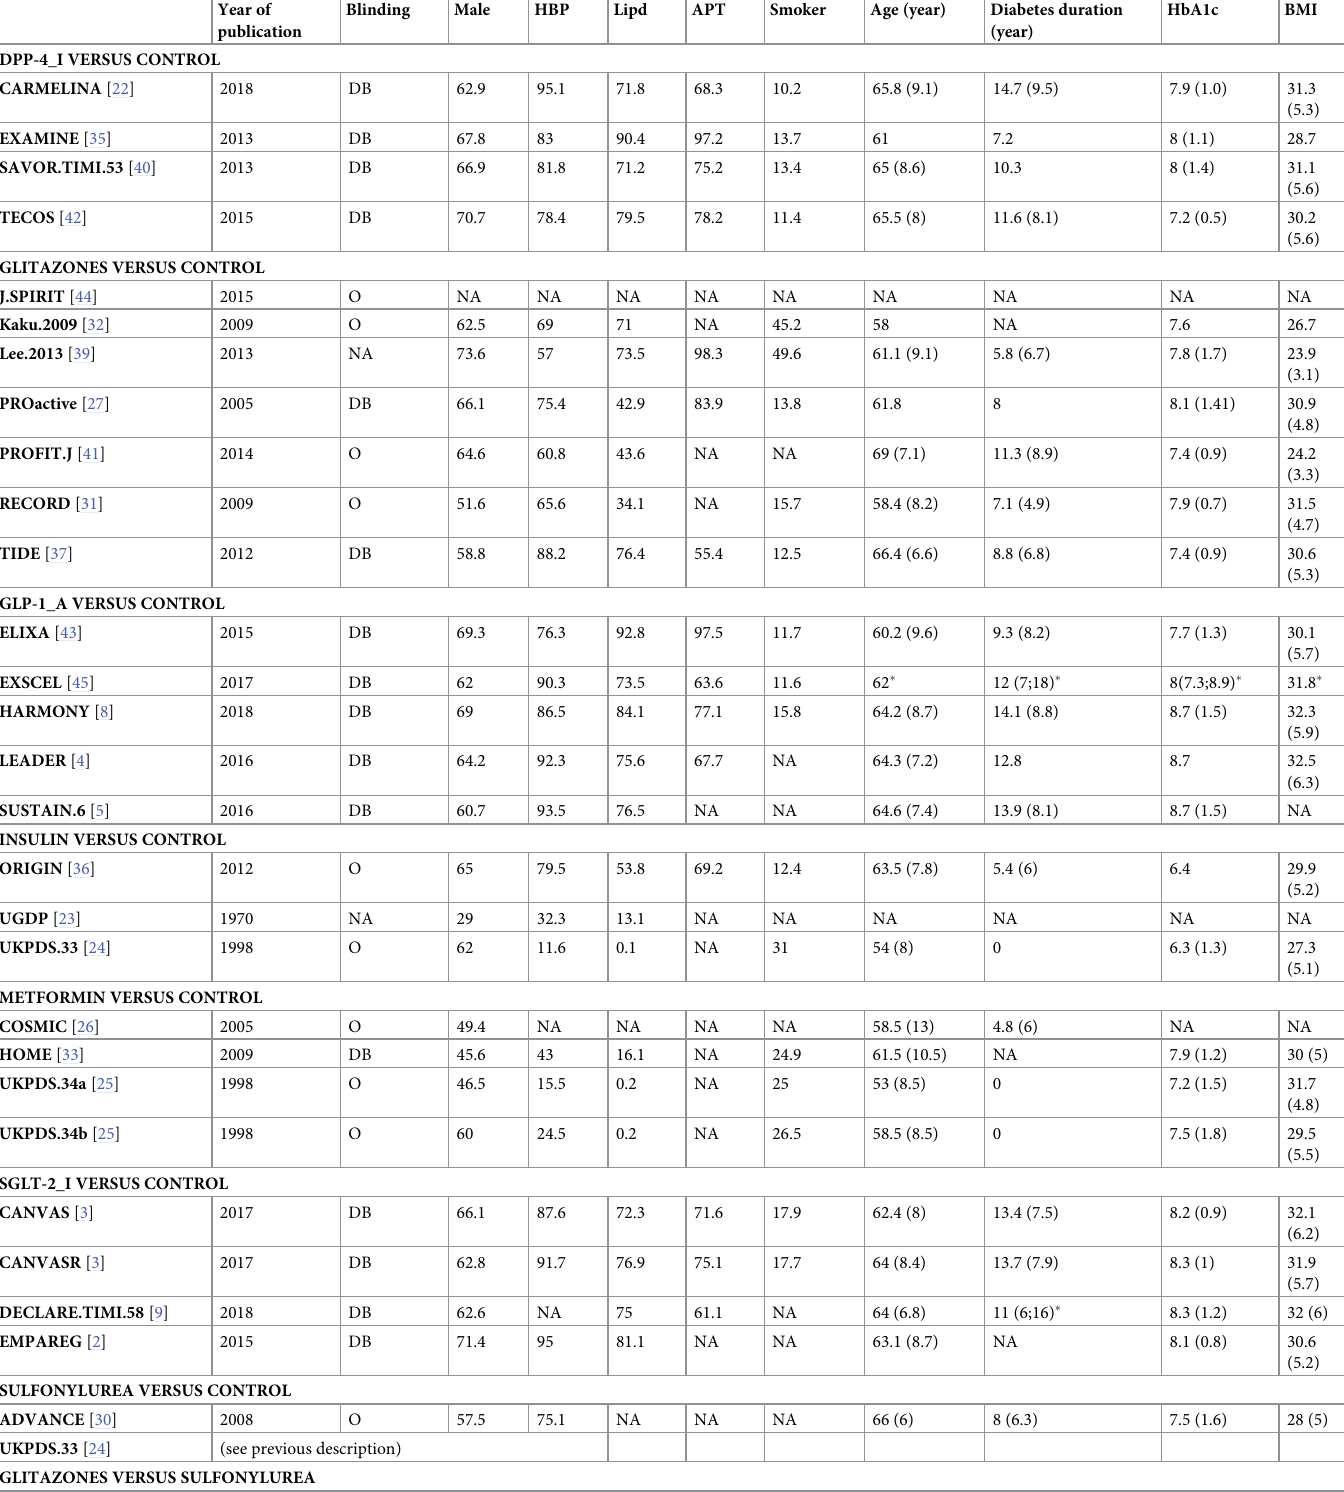
Table 1. Baseline characteristics of included